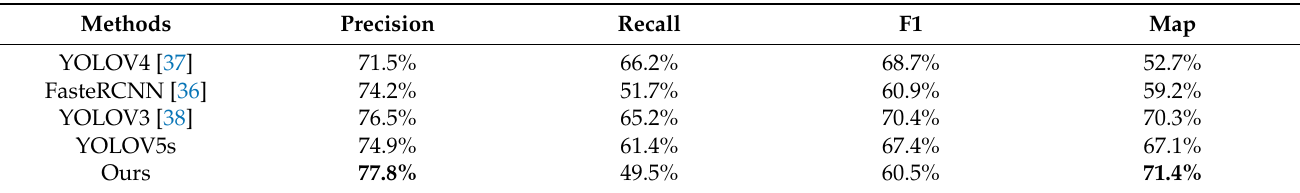
Table 7. The comparison between ours and existing models (public